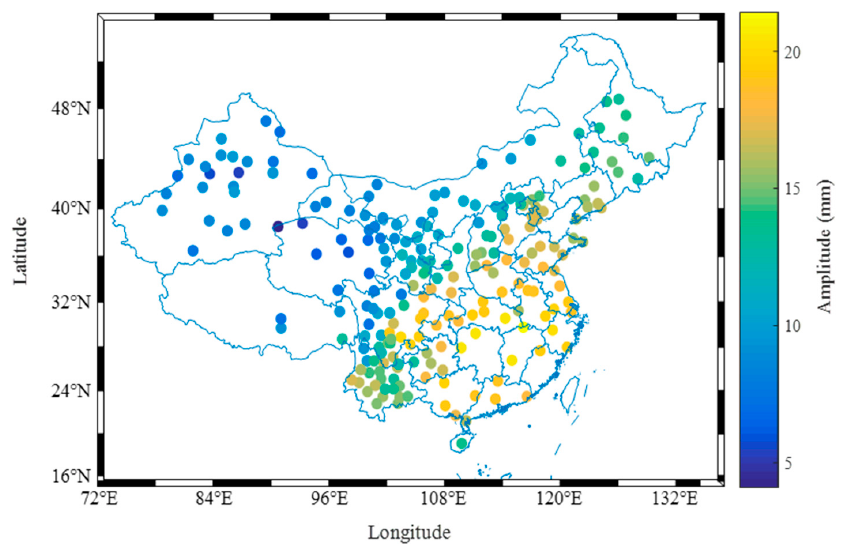
Figure 10. Annual PWV variation amplitudes (mm) at 377 GPS sites.